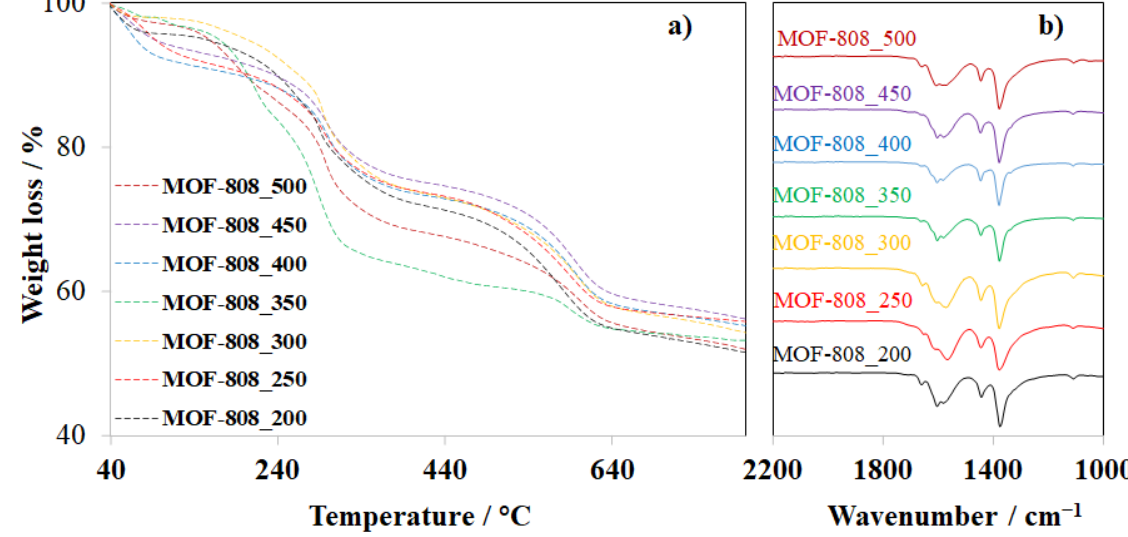
Figure 6. TGA results ( a ) and FT-IR spectra ( b ) of MOF-808 samples synthesized with various amounts of formic acid.